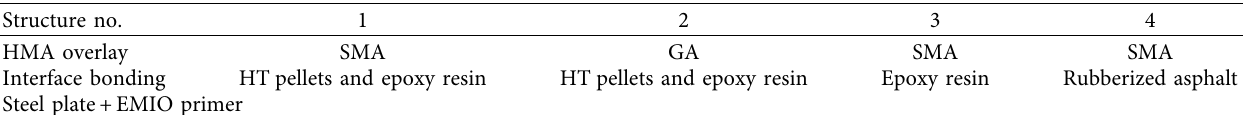
Figure 14: Five-point bending test setup. (a) Sketch of FPBT. (b) Specimen preparation. (c) LVDT setup. Table 3: Pavement structures for